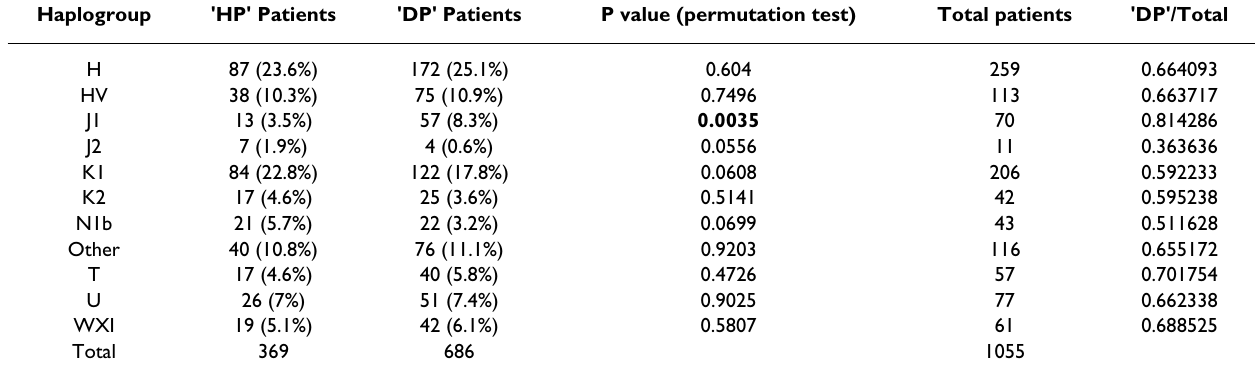
Table 1: Permutation test of haplogroup distribution among patients with T2DM parents (designated 'DP') versus patients with healthy parents (designated 'HP'). Haplogroup